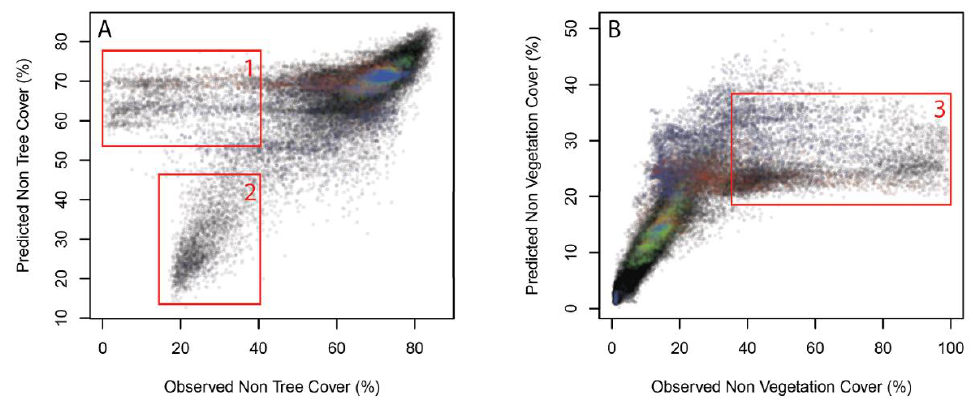
Figure 8. Observed vs. predicted NTC ( A ) and NVC ( B ): ( 1 ) low observed NTC with high predicted NTC; ( 2 ) good fit to the data; ( 3 ) predicted NVC saturation at around 20–40%; red = wildlife reserve; green = national parc; blue = controlled hunting area.